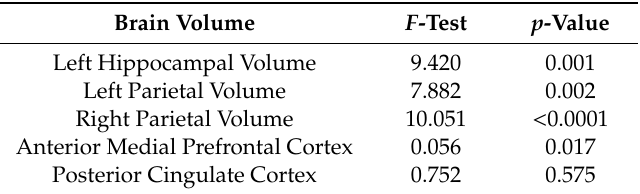
Table 2. Di ff erences in Control and sAD brain volumes. This table shows the significance of the di ff erences in brain volumes between controls and patients with sAD when controlling for age, years of education and brain